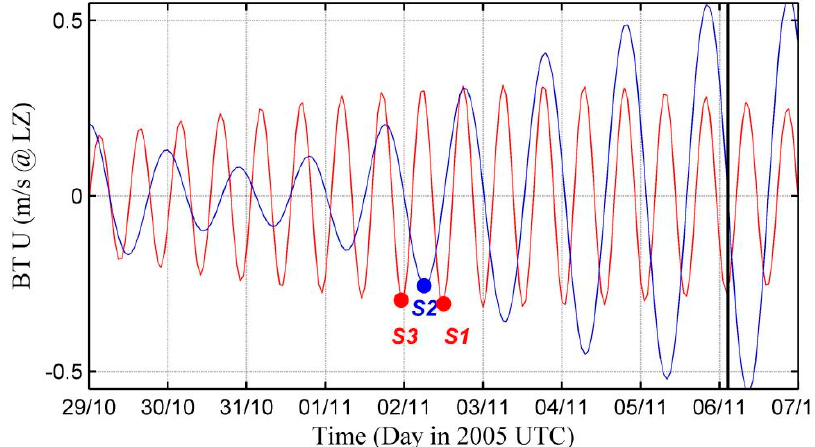
Figure 8. Semidiurnal (red) and diurnal (blue) components of zonal tidal current predictions (TPXO 7.2) in the Luzon Strait. The dots S1, S2, and S3 indicate the westward tidal current peaks corresponding to the S1, S2, and S3 NLIWs in Figure 7, respectively. The thick black line indicates the SAR imaging time in Figure 7.